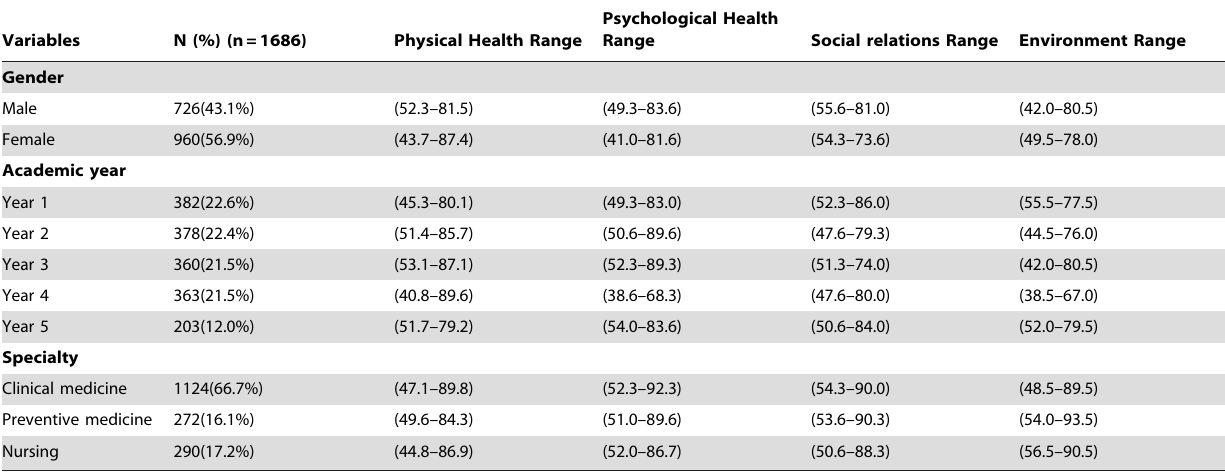
Table 1. Social demographic characteristics of medical students in the study.